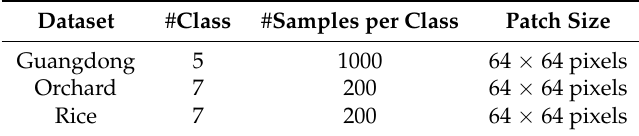
Table 1. Details of the Guangdong, Orchard and Rice datasets.